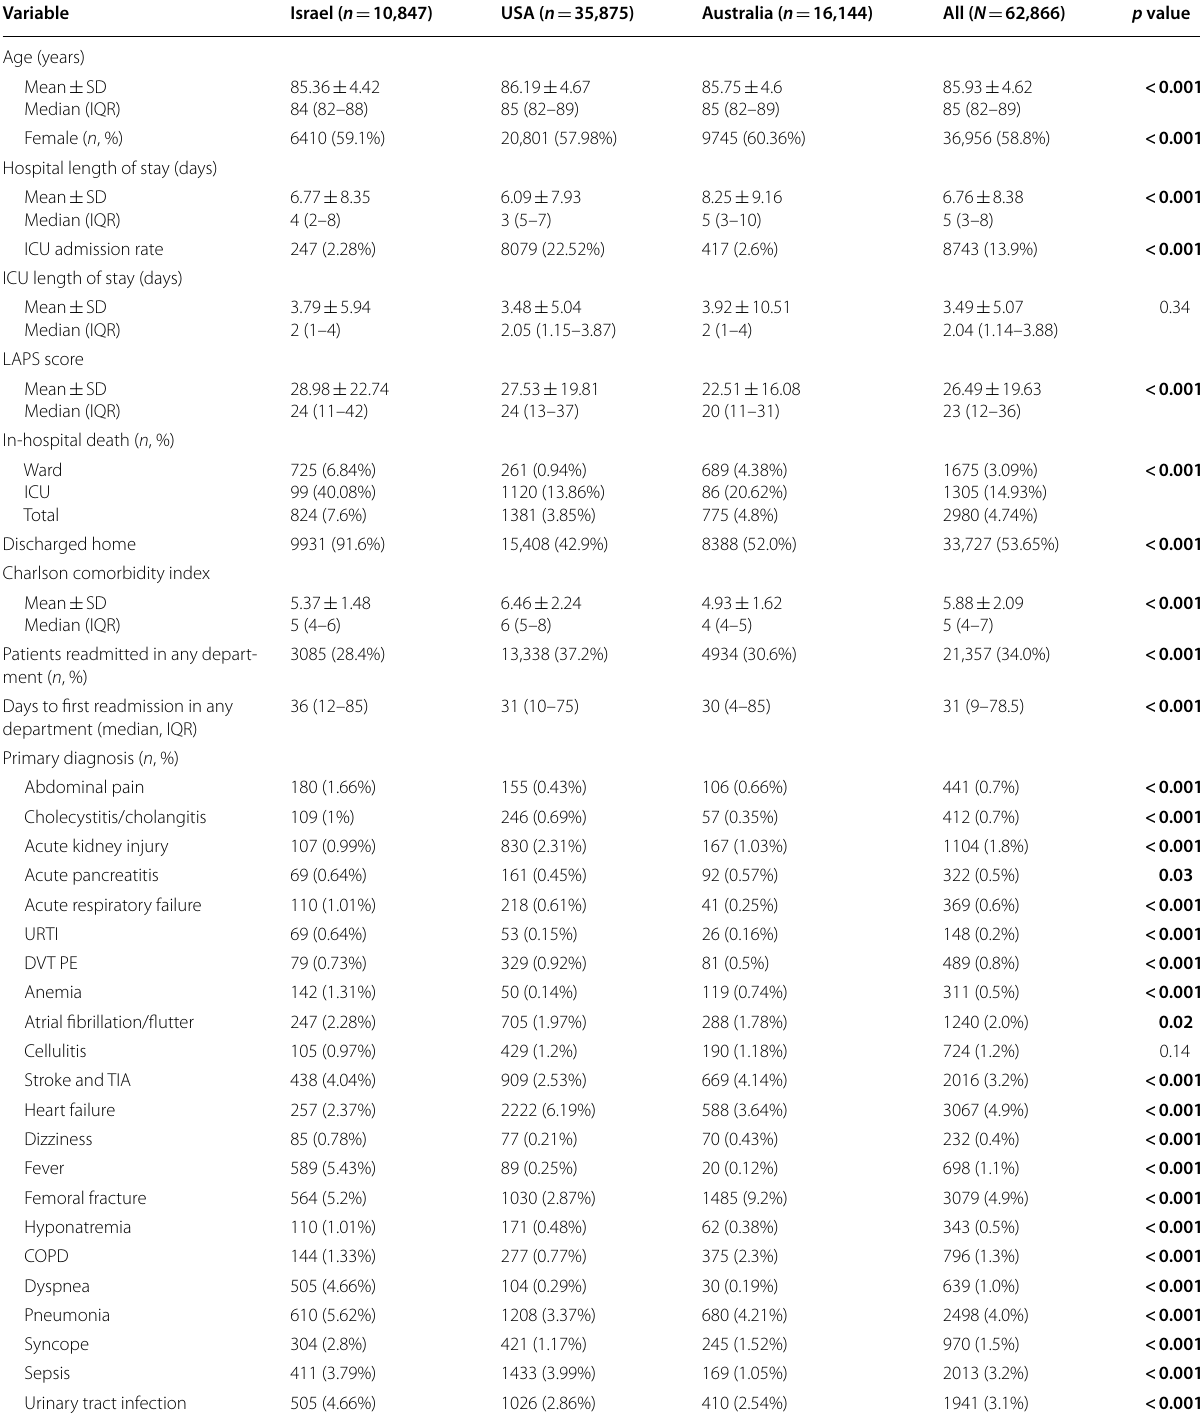
Table 1 Characteristics of the patients at first